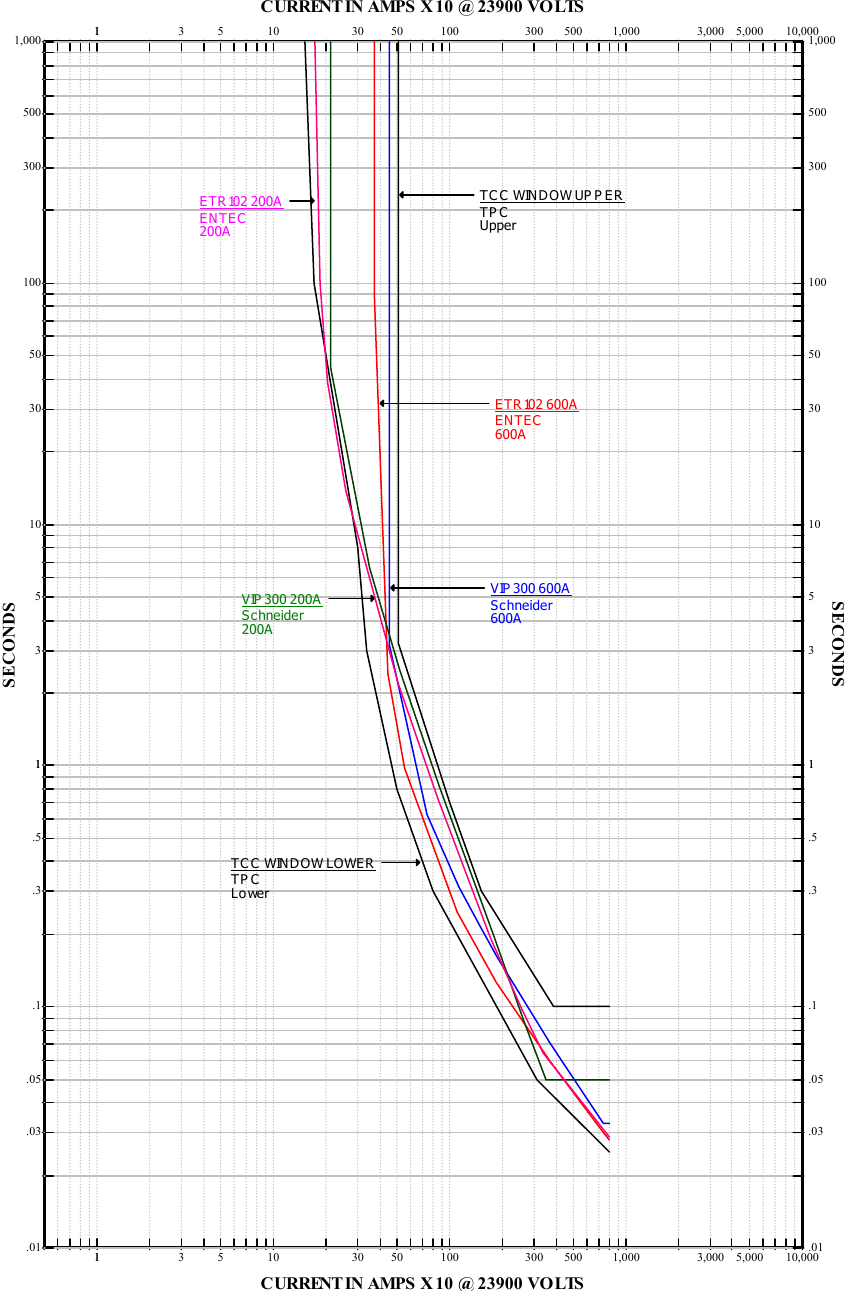
Figure 2. ETR102, VIP300, and TCC Window time current characteristic